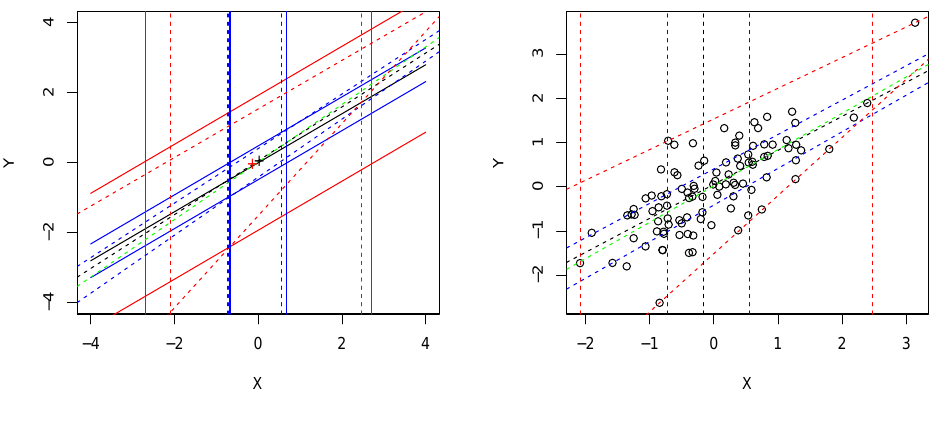
Figure 7: Empirical BBP (dashed lines) in option 1. b for the data in Example 2.1. The continuous lines represent the theoretical BBP and the dashed green lines the empirical regression line.